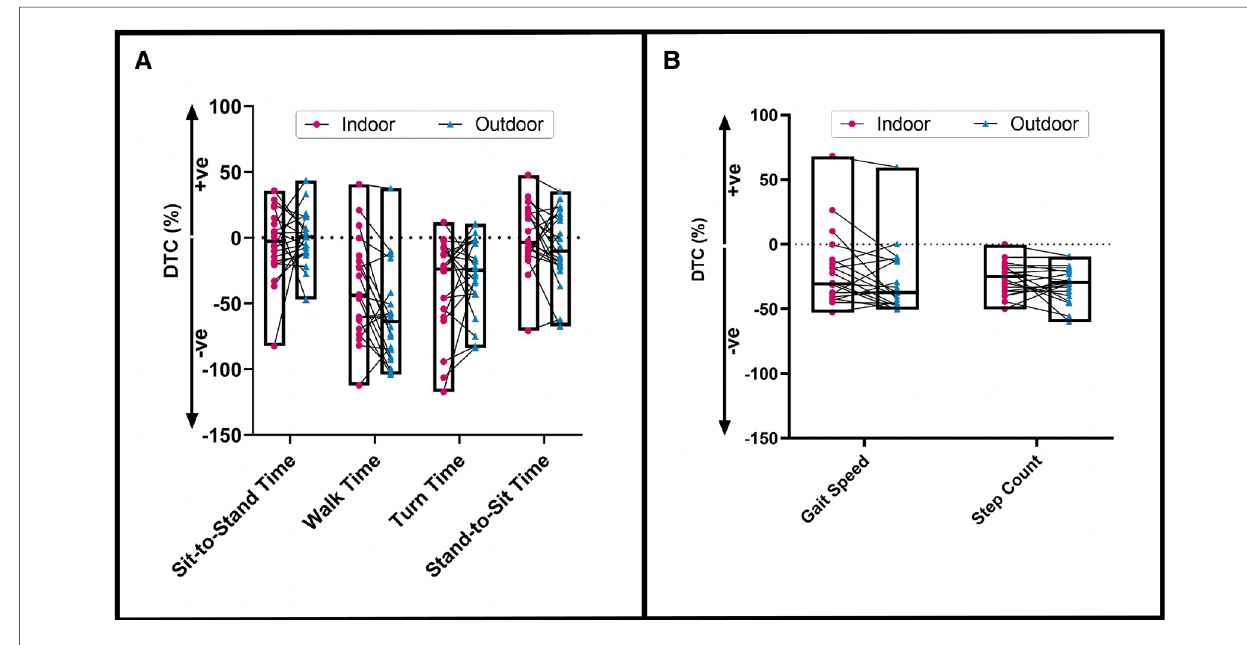
FIGURE 3 The dual-tasking cost (DTC) of the ( A ) sit-to-stand time, walk time, turn time, and stand-to-sit time and ( B ) gait speed and step count in indoor (in red color) and outdoor (in blue color) environments while texting. The box plot depicts the median values of DTCs. To note, (+ve) indicates an improvement in dual-tasking performance, and ( − ve) indicates a decline in dual-tasking